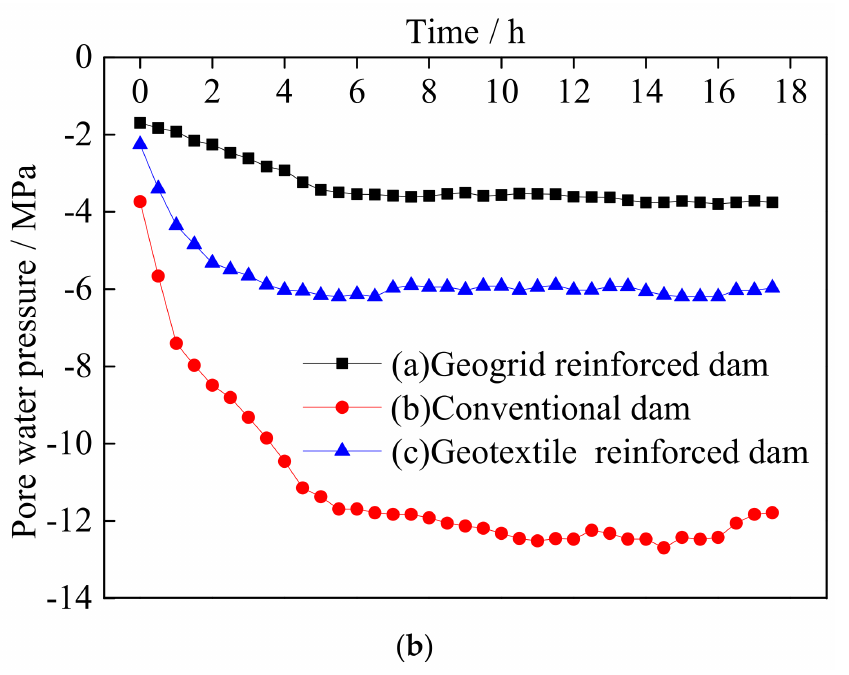
Figure 13. Comparison of PWP over time in the three tailings dams: ( a ) vertical direction; ( b ) horizontal direction.